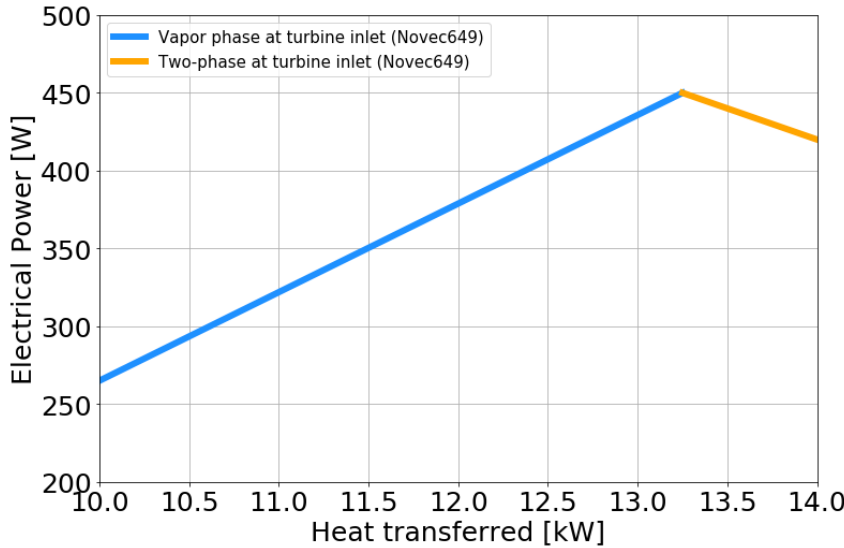
Figure 19. Electrical power production based on the heat source (smoothed curve).